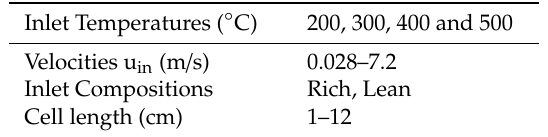
Table 3. Simulation conditions for the determination of mass and heat transfer coe ffi